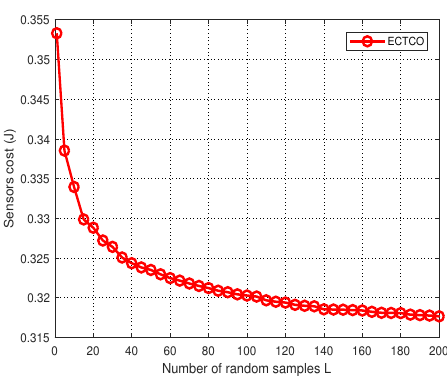
Figure 3. Sensors cost versus the number of random samples L .